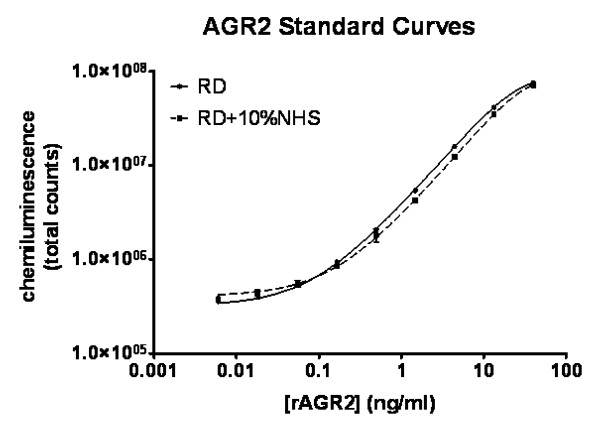
AGR2 ELISA standard curves. rAGR2 was diluted in either 1× Reagent Diluent (RD) or RD supplemented with 10% normal human serum (RD+10%NHS). A 3-fold dilution series of rAGR2 (from 40 ng/ml to 0.006 ng/ml) was generated in RD or RD+NHS. AGR2 ELISA was used to measure the signal for each sample in RD (closed circles) or RD+10%NHS (closed squares). Standard curves were generated for AGR2 in RD (solid line) or RD+10%NHS (dashed line) using the five-parameter log-logistic method (r2 = 0.999 for both curves). The average of three replicates is presented. Error bars represent one standard deviation and are almost not apparent due to low intra-assay standard deviations.